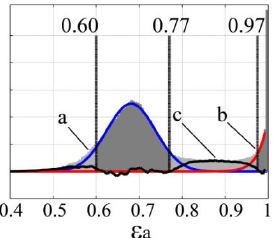
Fig. 4. (a) Mean value and (b) standard deviation for relative humidity W a Fig. 3. Pdf of the atmospheric emissivity 5-min values from 2005